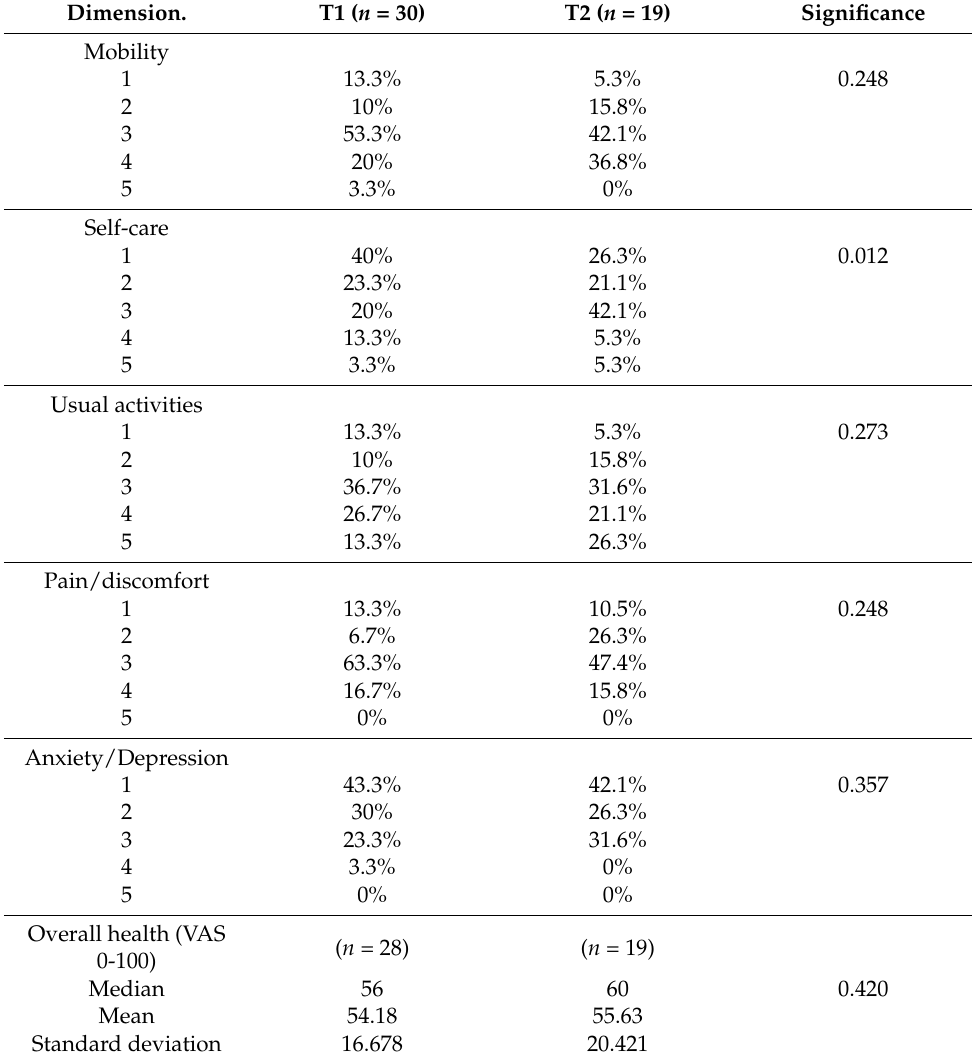
Table 4. EQ-5D-5L results for the sample with significance tested for pairs ( n = 19). Note: two participants declined to complete Visual Analogue Scale (VAS) of overall health ‘today’.